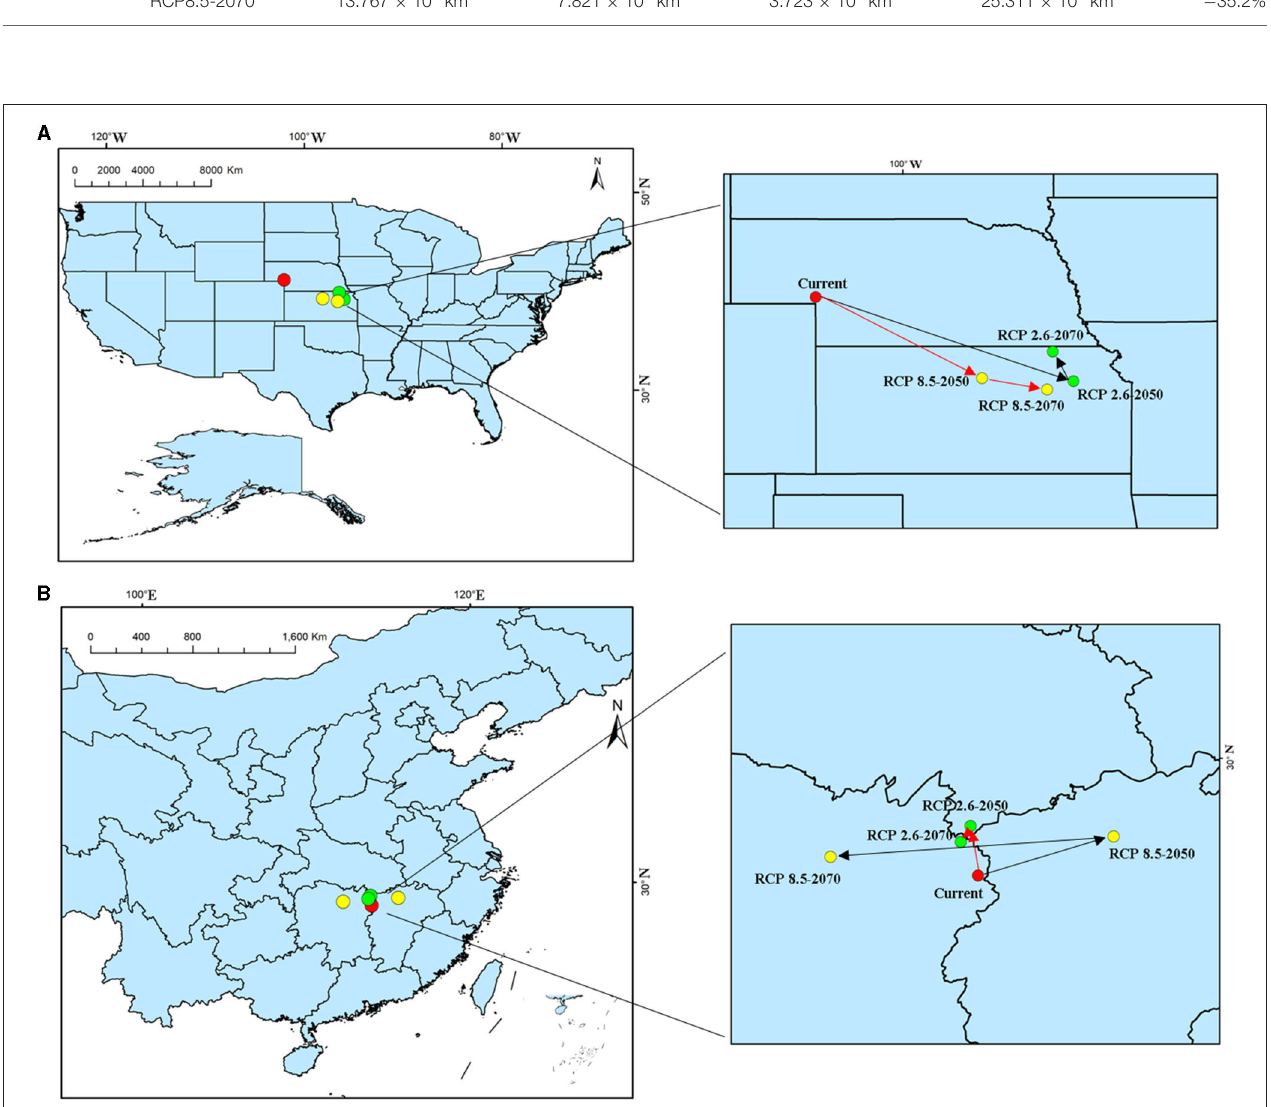
Frontiers in Plant Science |